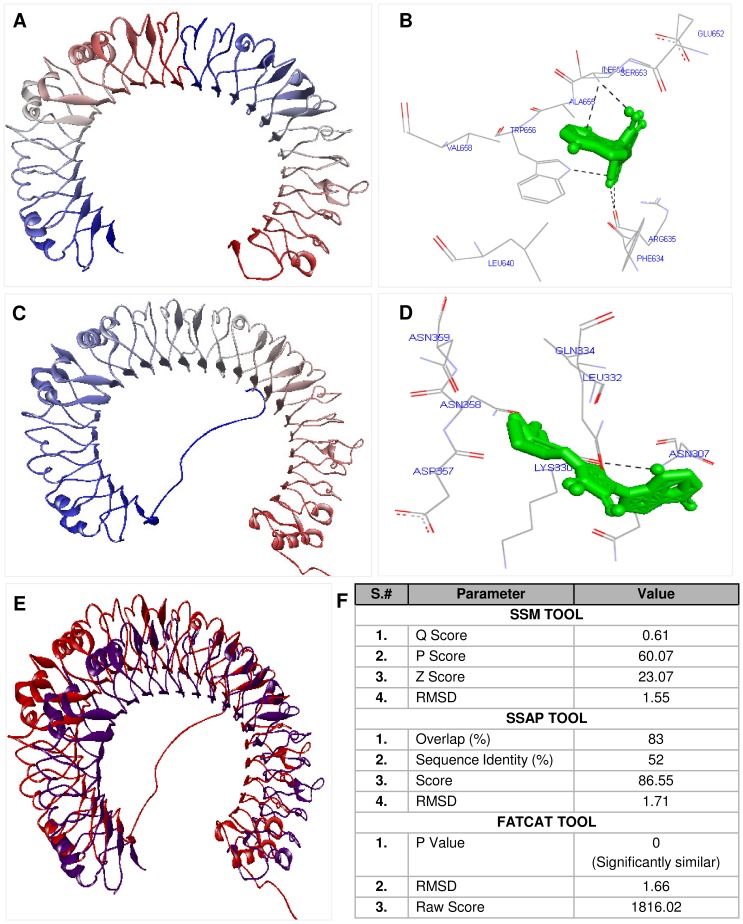
Homology modeling of shTLR3 ectodomain and docking with the synthetic dsRNA ligand poly I:C.The good model of human TLR3 (A) and shTLR3 (C) ectodomain that satisfies the various stereo-chemical constraints (predicted by atleast 4 models); E - The overlapped structure of both human and shTLR3; B & D – reveals the binding of the human and shTLR3 respectively with poly I:C reveals the difference in the number of hydrogen bonds and interacting amino acid residues.